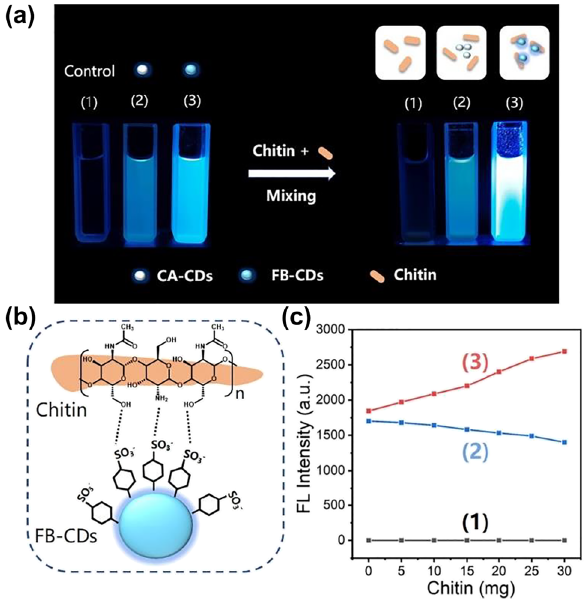
Figure 4: The chitin-targeting capability of FB-CDs. (a) FL images of (1) water (control), (2) CA-CDs, and (3) FB-CDs under UV irradiation. The CD solutions were compared at the same concentration. (b) Schematic illustration of the binding mechanism chitin to FB-CDs. (c) Fluorescence intensities of CD solutions after mixed with different chitin